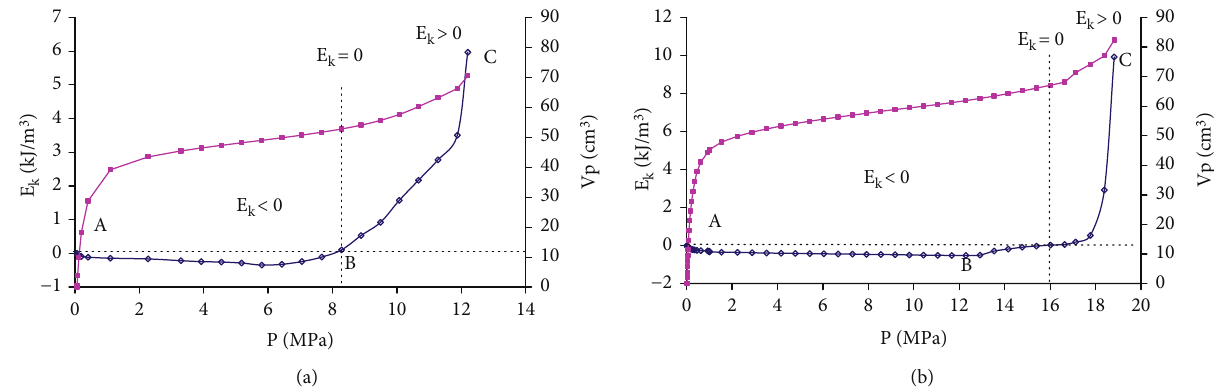
Figure 7: Comparison of the pore water pressure and energy and water volume curves of hydrofracture. (a) Uniaxial compression hydrofracture curve. (b) Triaxial compression hydrofracture curve.